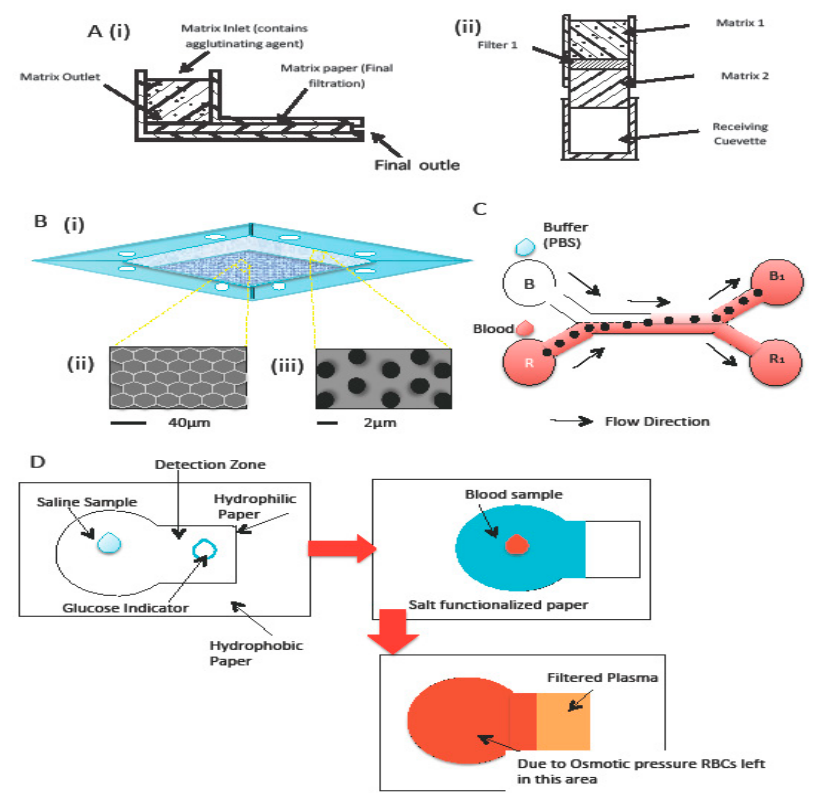
Figure 4. ( A ) Filter that uses matrix of a hydrophilic sintered porous material with different designs taken from Ref. [54]. Panel ( B ) (i) shows a 3D parylene-filter design by Liu et al. Images are modified from [55], where panel ( B ) (ii) shows 40 µ m micropores that prevent clogging and panel ( B ) (iii) shows 2 micropores for plasma filtration. ( C ) H-filter paper-based device used by Kar et al. Image are modified from [56]. ( D ) Salt-functionalized paper used to separate plasma from blood by Nilghaz and Shen. Images are modified from